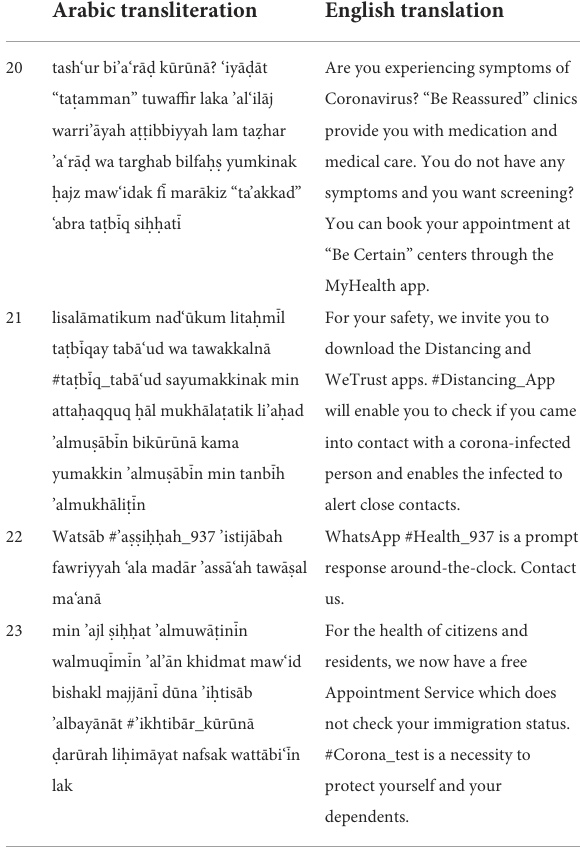
TABLE 7 Examples of the use of the reciprocity pattern. Arabic transliteration